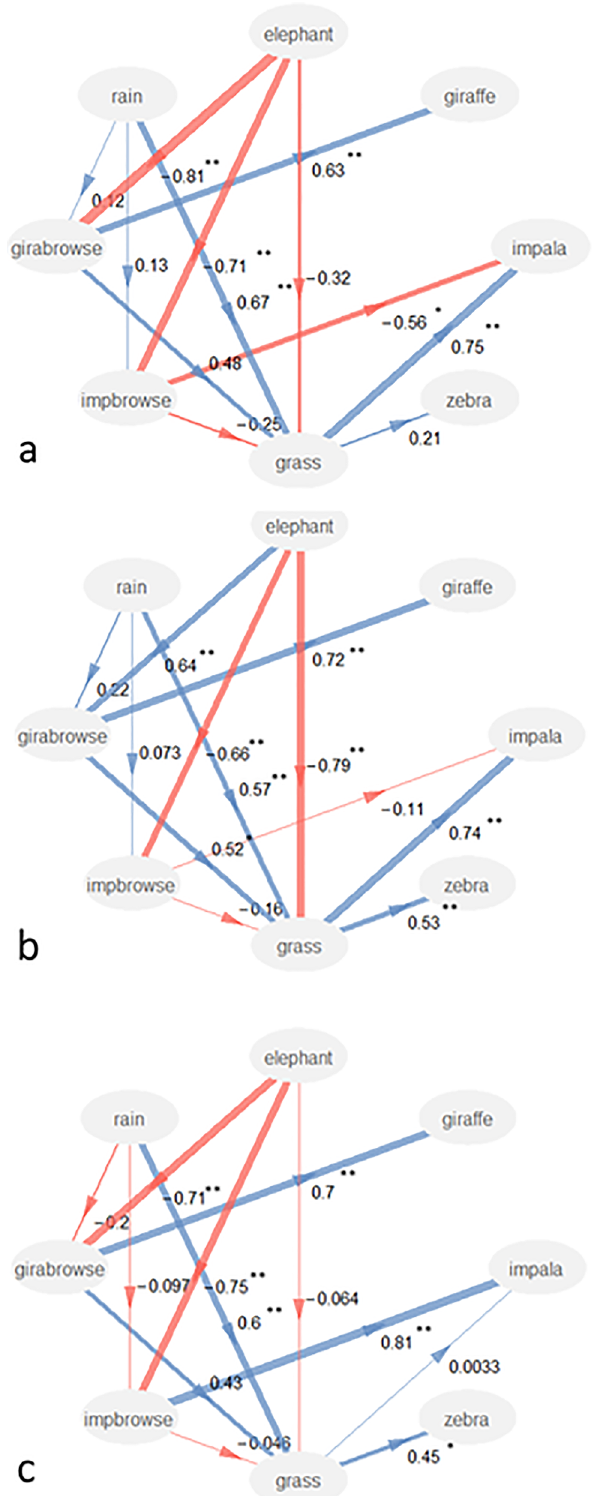
Fig 4. Results of the path models per reserve. Results of the path model for (a) Balule Game Reserve, (b) Kapama Game Reserve and (c) Sabi Sand Wildtuin. Circles are latent variables and arrows interactions. Numbers are regression